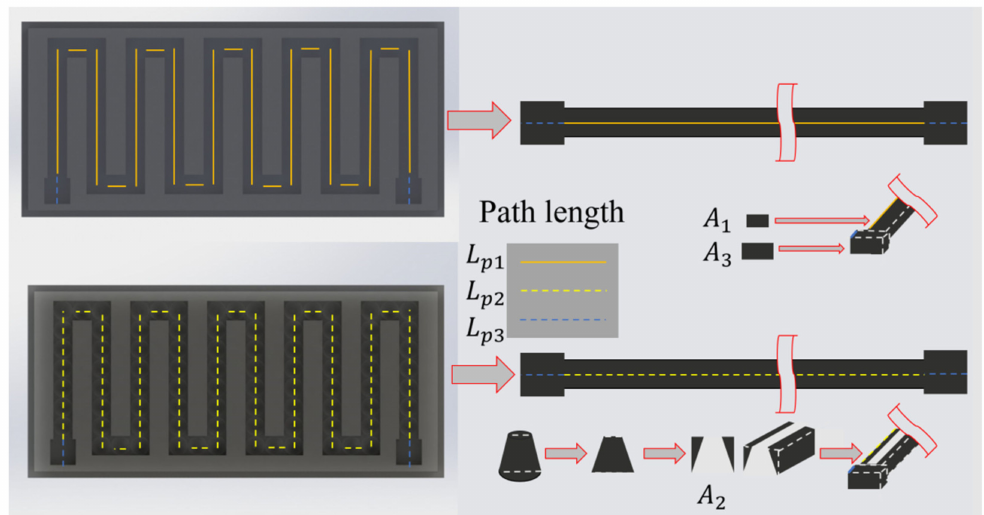
Figure 14. Definition of the geometrical parameters used to estimate the resistances of the normal- and bump-type EGaIn soft